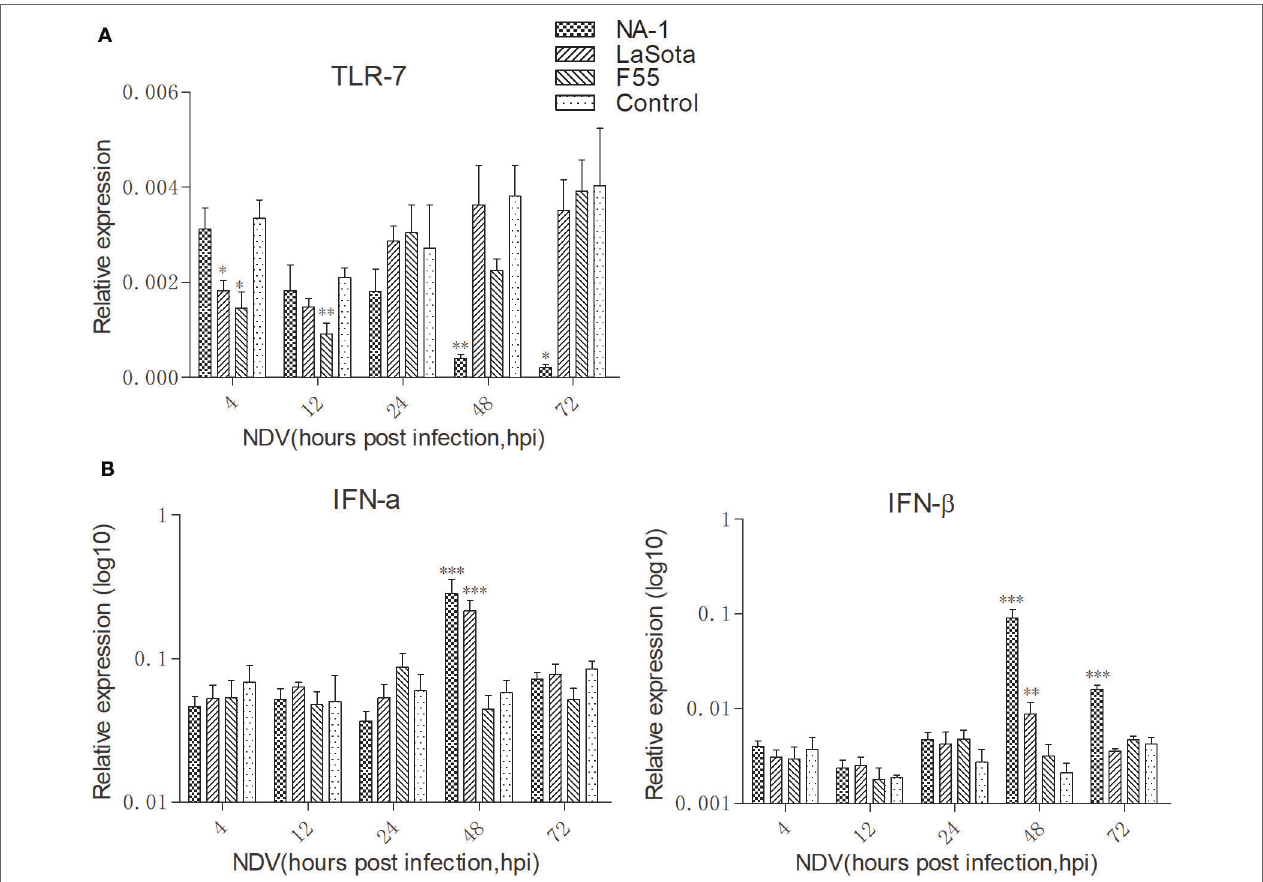
FigUre 4 | Virulent Newcastle disease virus (NDV) inhibit TLR7 expression but induce higher expression of type I interferons (IFNs) in chicken macrophages at the late stage of viral infection. Expression levels of TLR7 (a) and type I IFNs [IFN- α and IFN- β , (b) ] in HD11 cells upon three different virulence and genotypes viruses for 4 to 72 h was quantified by qPCR. All qPCR data were normalized to the geometric mean of cellular endogenous genes β -actin and hydroxymethylbilane synthase and calculated using the 2 - Δ Ct method. All values are shown as mean ± SEM ( n = 4–6) and differences were considered significant if * P < 0.05, ** P < 0.01, *** P < 0.001 as compared to the respective control (uninfected) cells. All data are representative of at least three independent